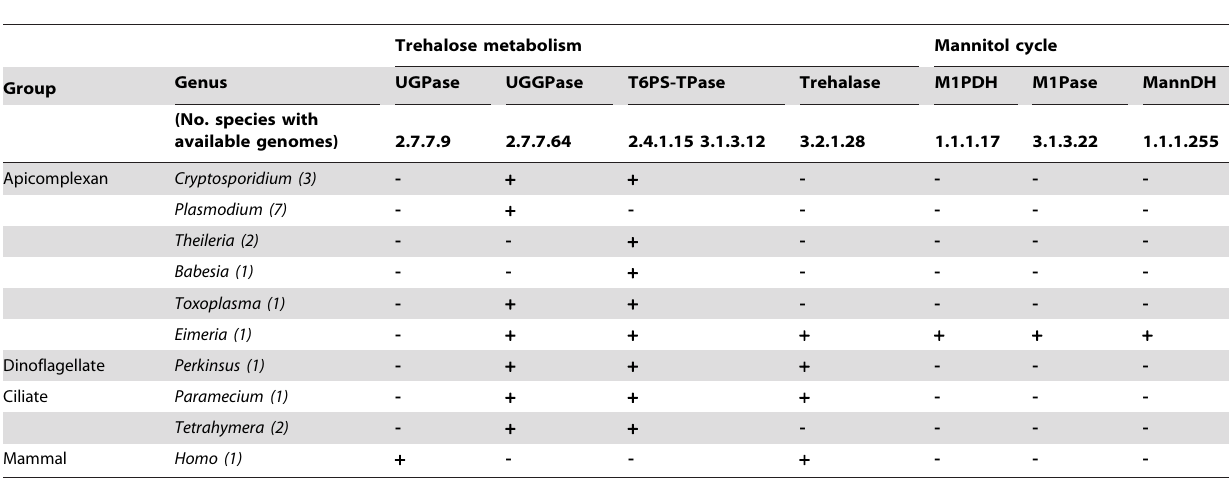
Table 1. Evidence of trehalose synthetic pathways in Cryptosporidium and some other apicomplexans and alveolates as shown by the presence of genes encoding UDP-galactose/glucose pyrophosphorylase (UGGPase), Class II trehalose-6P synthase-trehalose phosphatase (T6PS-TPase) in their